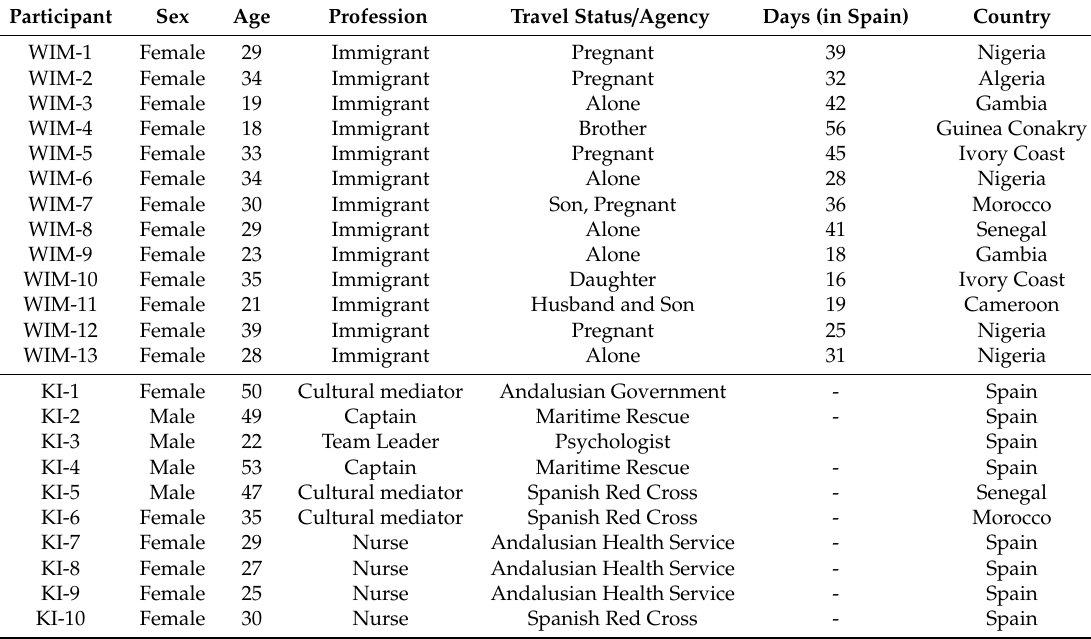
Table 1. Socio-demographic data of the participants ( N =